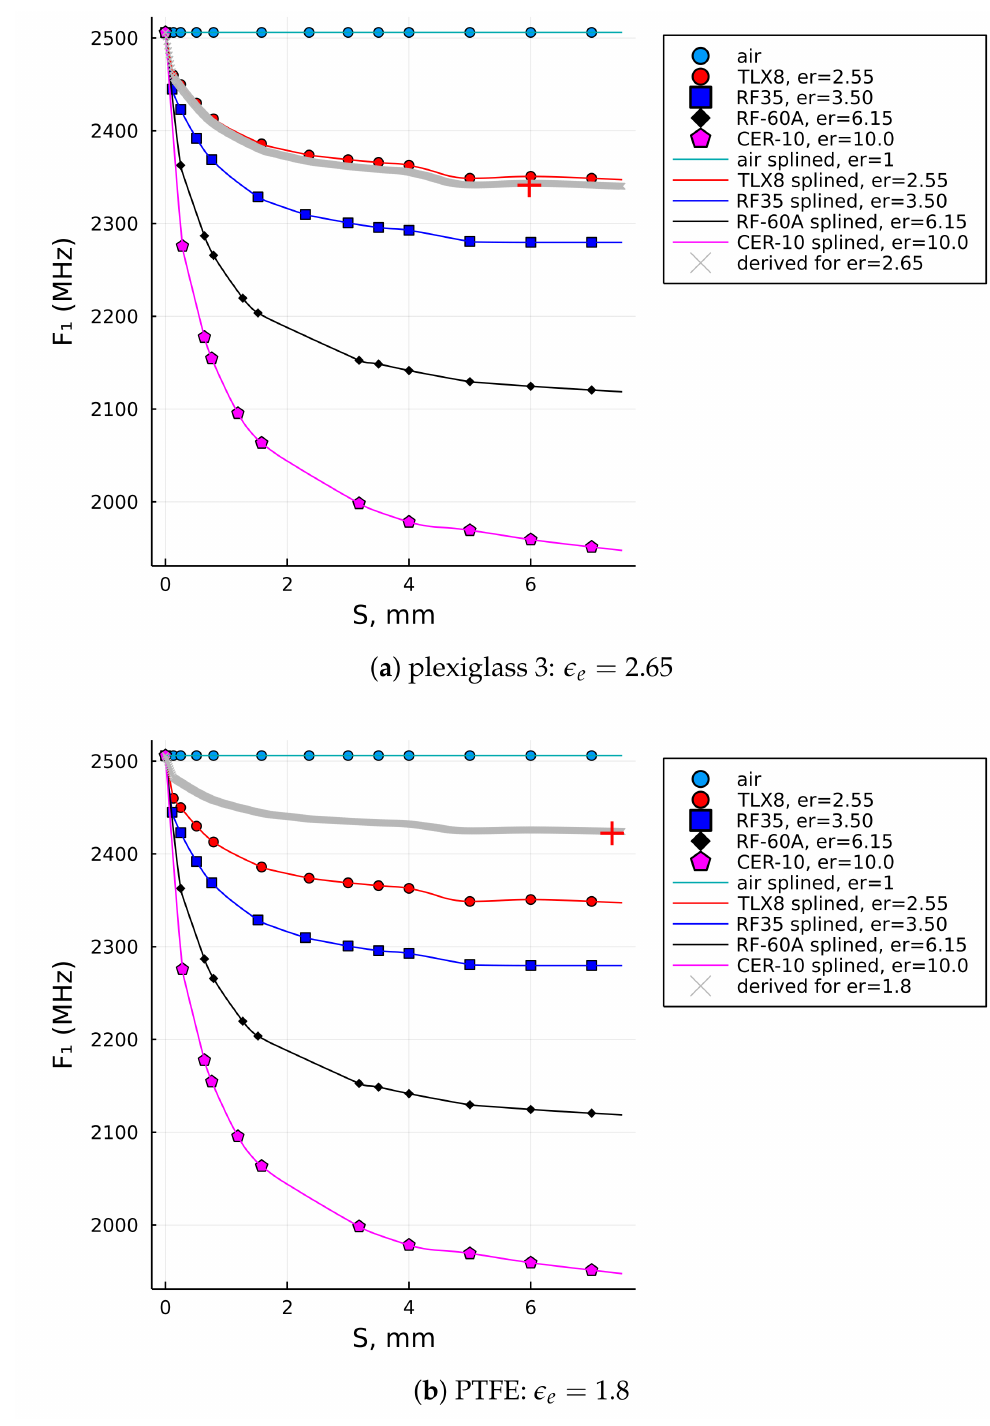
Figure 9. SUT permittivities computed by the proposed algorithm for plexiglass 3 and PTFE samples: ( a ) for plexiglass 3. ( b ) for